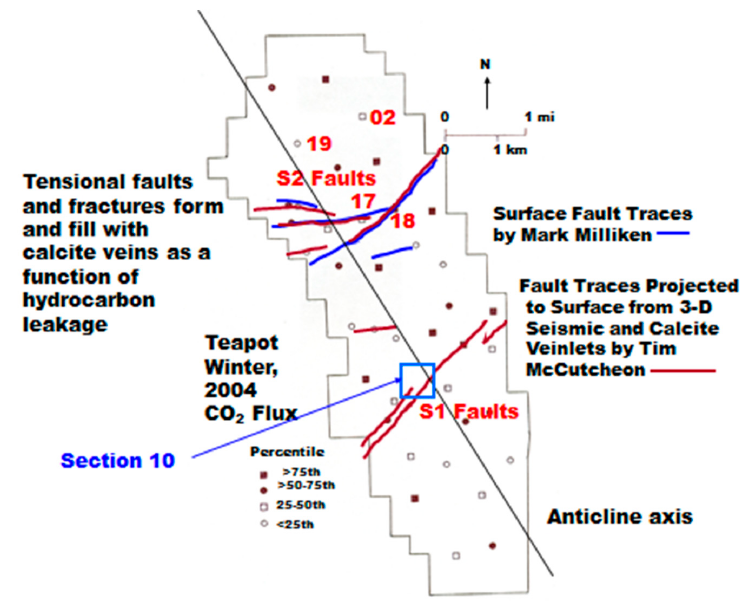
Figure 5. Outline of the Naval Petroleum Reserve #3 (NPR#3) with gas flux locations. The symbols for locations 17 and 18 are mostly covered by the S2 fault trace.